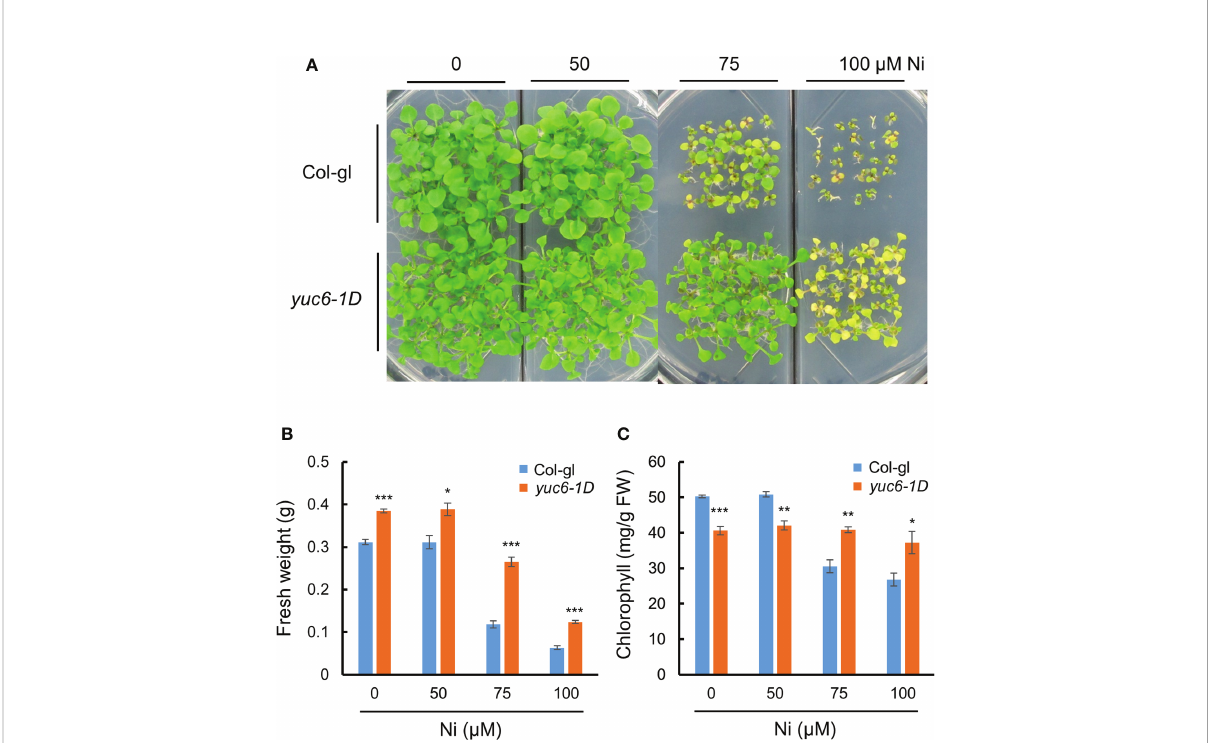
FIGURE 2 Dominant mutant yuc6-1D shows Ni stress tolerance. Phenotypes (A) , fresh weight (B) , and chlorophyll contents (C) of wild-type (WT, Col-gl) and yuc6-1D plants grown on 0, 50, 75, or 100 m M Ni for 2.5 weeks after germination. Values are means ± SE of three independent biological replicates. Asterisks indicate signi fi cant differences (* p < 0.05, ** p < 0.01, and *** p < 0.001) from the WT determined using two-tailed Student ’ s t